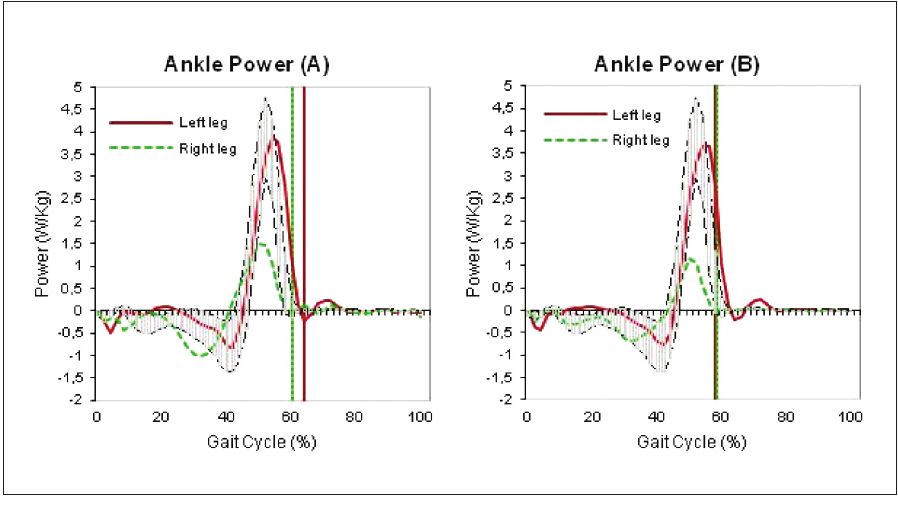
Figure 3. Ankle joint power